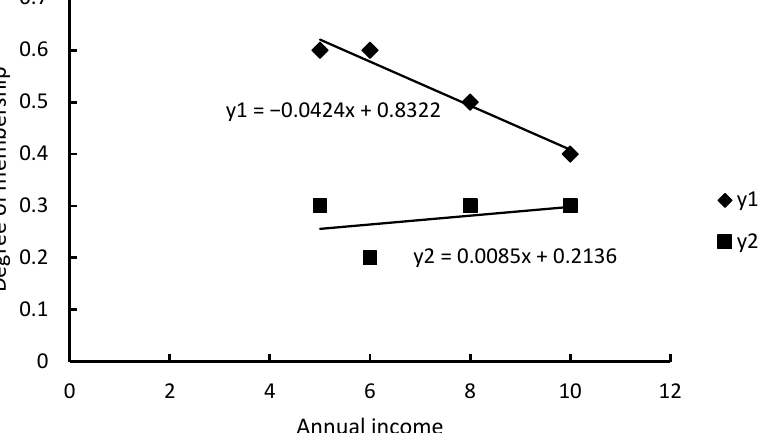
Figure A8. Single factor evaluation for the index of annual income (0–5 (inclusive) ten thousand yuan).